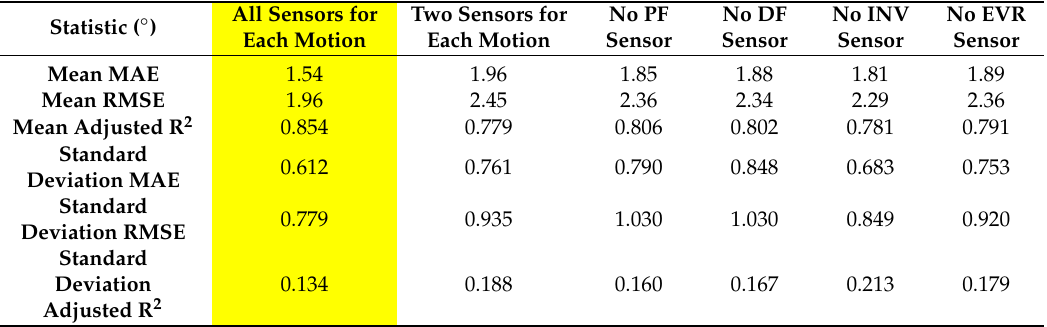
Table 1. Results for various combinations of multivariate linear models to predict motion output. Best results